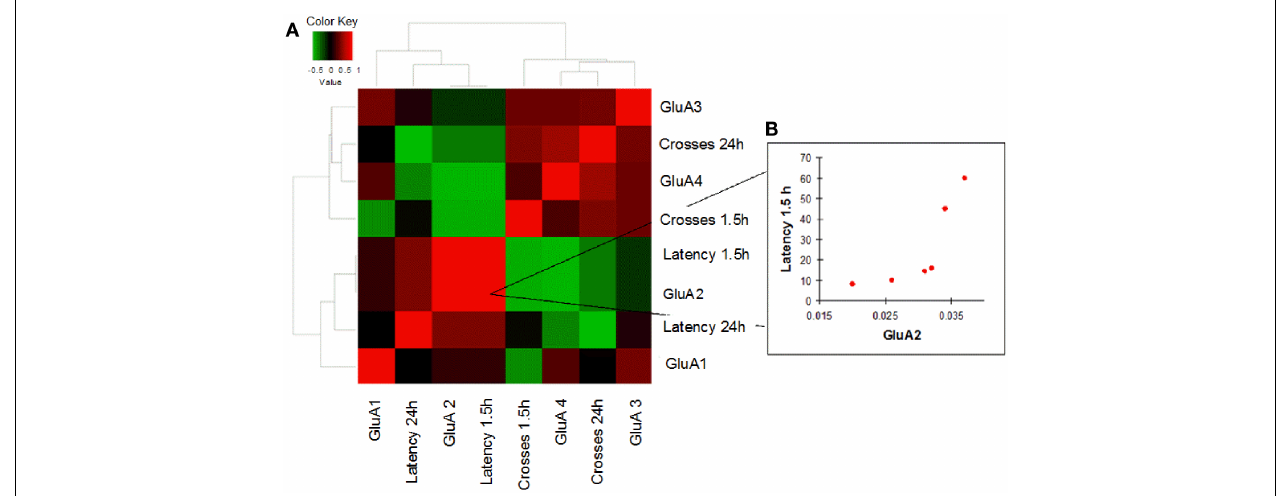
and MWM parameters (latency and crosses) in young 3xTg-AD mice. Direct and inverse correlations are shown in red and green, respectively. (B) 3xTg-AD mice showed a direct correlation between GluA2 and MWM latency at